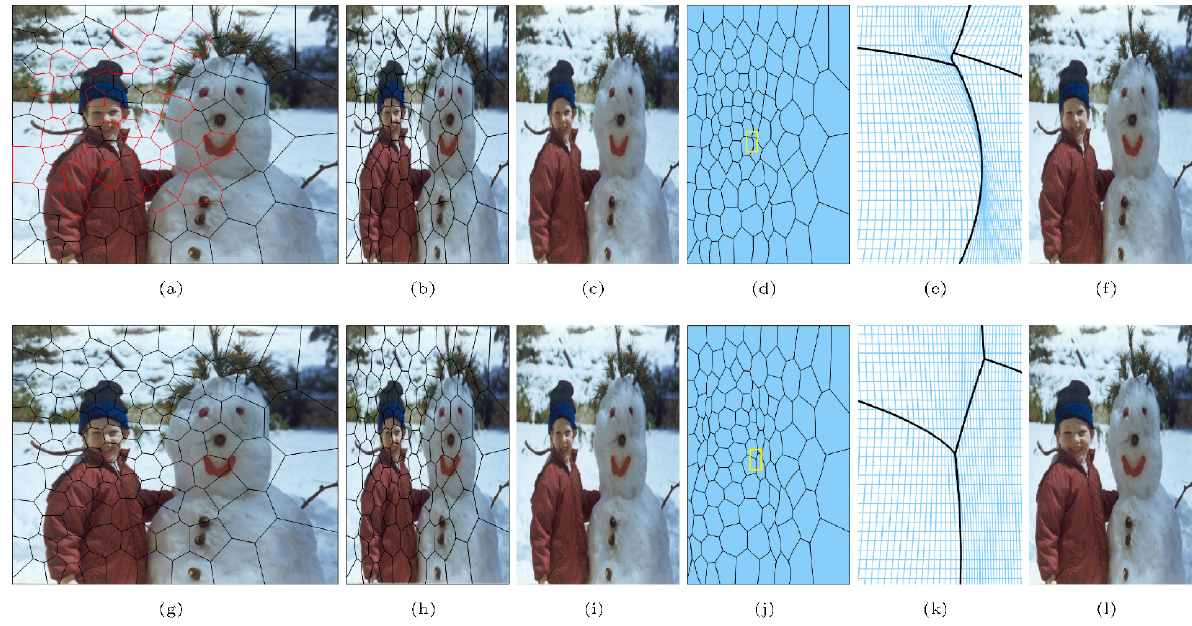
Fig. 5 Optimized warping meshes and results for different input polygonal meshes and with different constraints. Above: results for input polygons with short edges. Below: results for input mesh with short edges removed. (a) Polygonal mesh containing short edges; cells incident to an edge shorter than 5% of the mean edge length are marked in red. (b, c) Deformed mesh and result under sufficient constraints. (d) Deformed polygonal mesh under relaxed constraints. (e) Close up view of a non-bijective region in (d). (f) Warping result using warped polygonal mesh in (d). (g) Polygonal mesh with short edges removed. (h, i) Deformed mesh and results under sufficient constraints. (j) Deformed polygonal mesh under relaxed constraints. (k) Close up view of a region in (j). (l) Warping result based on the polygonal mesh in